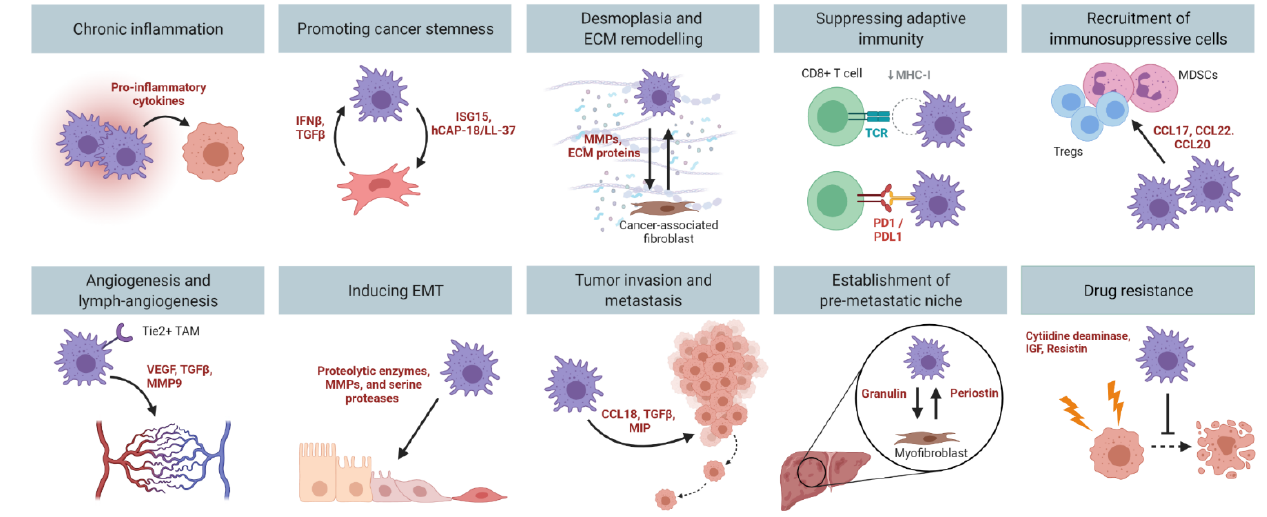
Figure 3. The multi-faceted role of TAMs in PDAC. Macrophages promote PDAC development and progression by contributing to chronic inflammation, promoting cancer stemness, desmoplasia, immune suppression, angiogenesis, inducing EMT, tumor invasion and metastasis, and mediating drug resistance. Figure created in Biorender.